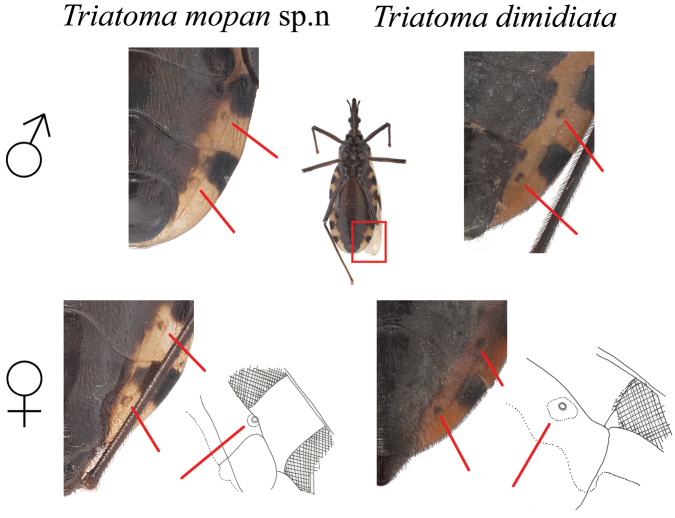
Comparison between the position and color of the abdominal spiracles from T.
mopan and T.
dimidiata from Jutiapa, Guatemala. Drawings by Carolina Dale. Photographs Silvia Justi and Raquel Lima.